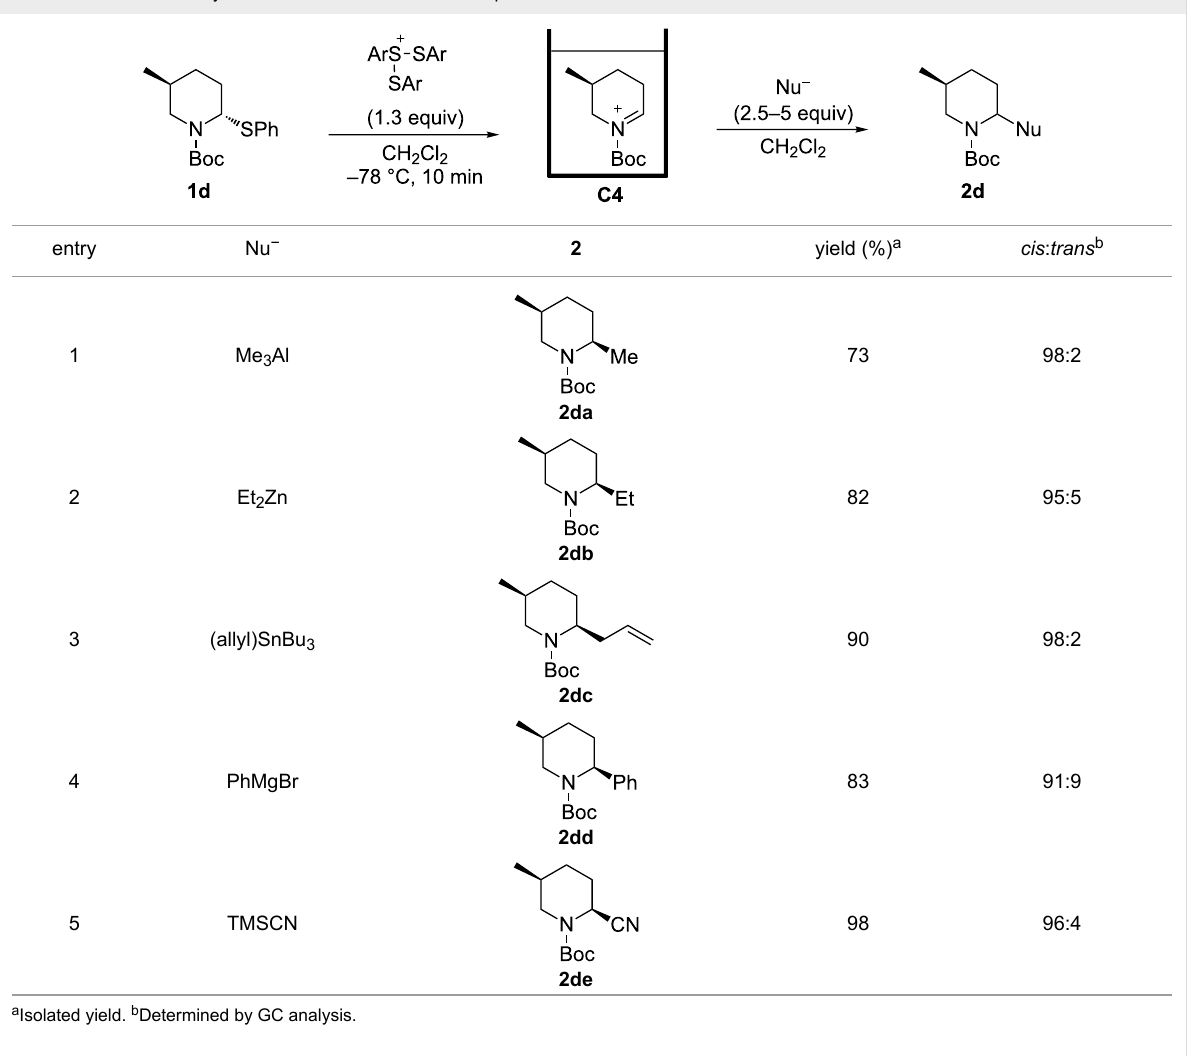
Table 4: Reaction of N- acyliminium ion C4 with several nucleophiles.